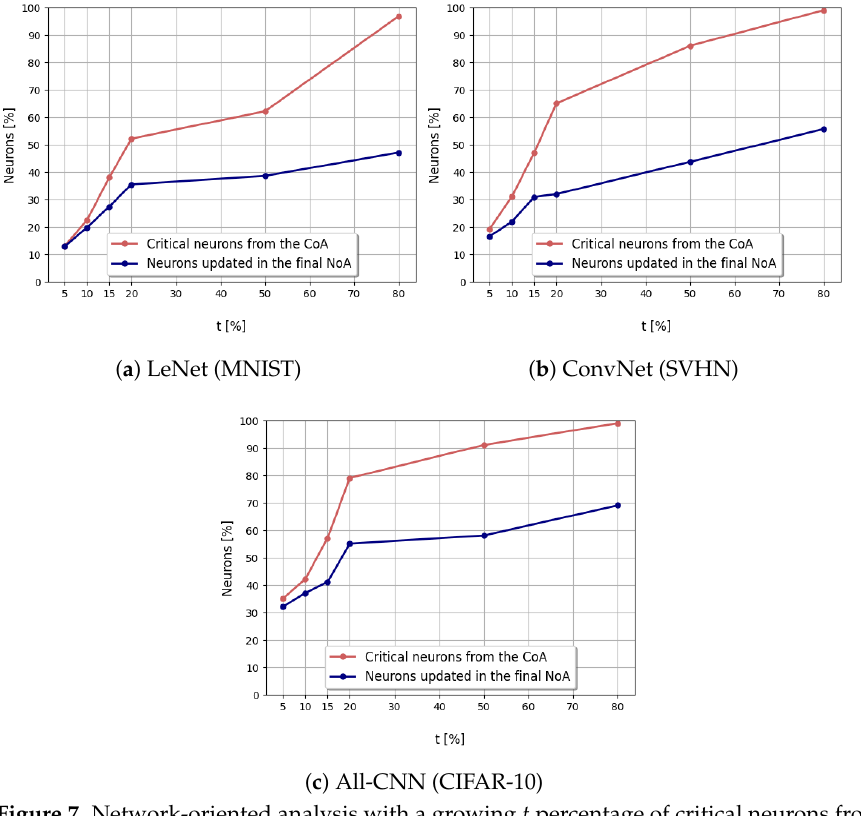
Figure 7. Network-oriented analysis with a growing t percentage of critical neurons from the class- oriented analysis (CoA). A study on the influence of the CoA on the NoA with a growing t